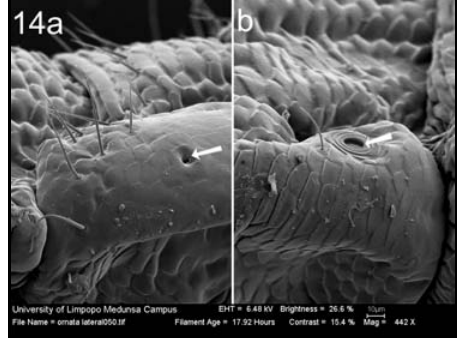
Fig. 14 a & b. Six pairs of abdominal spiracles (Fig. b) (arrow) were present whilst the second segment only showed a stigmatal scar (Fig. a) (arrow).